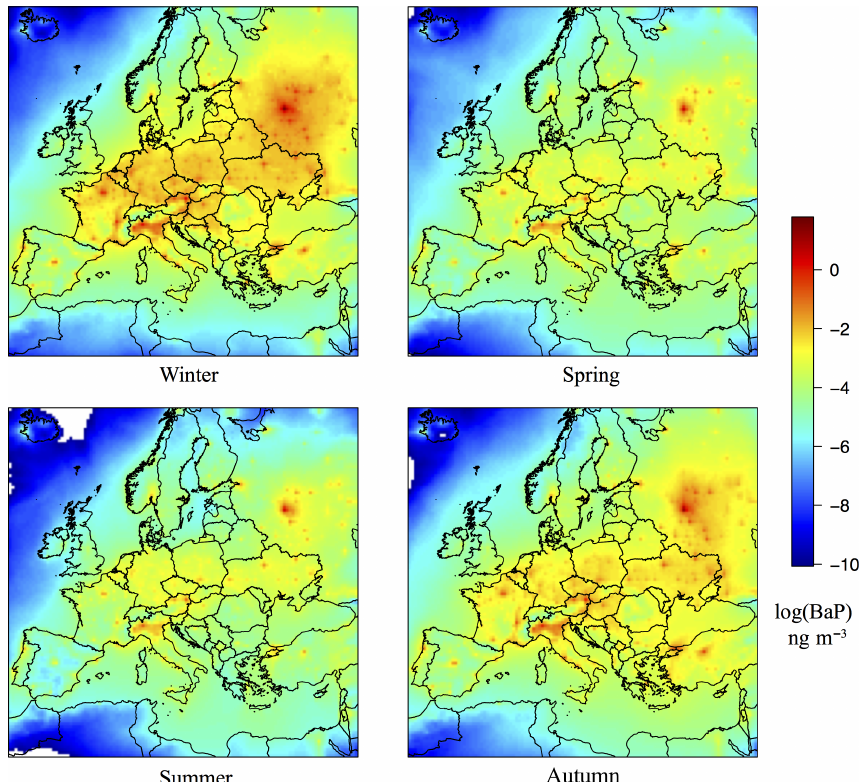
Figure 4. Seasonally disaggregated average surface-level BaP concentration [log c BaP (ngm − 3 ) ] maps predicted by scenario 4 during